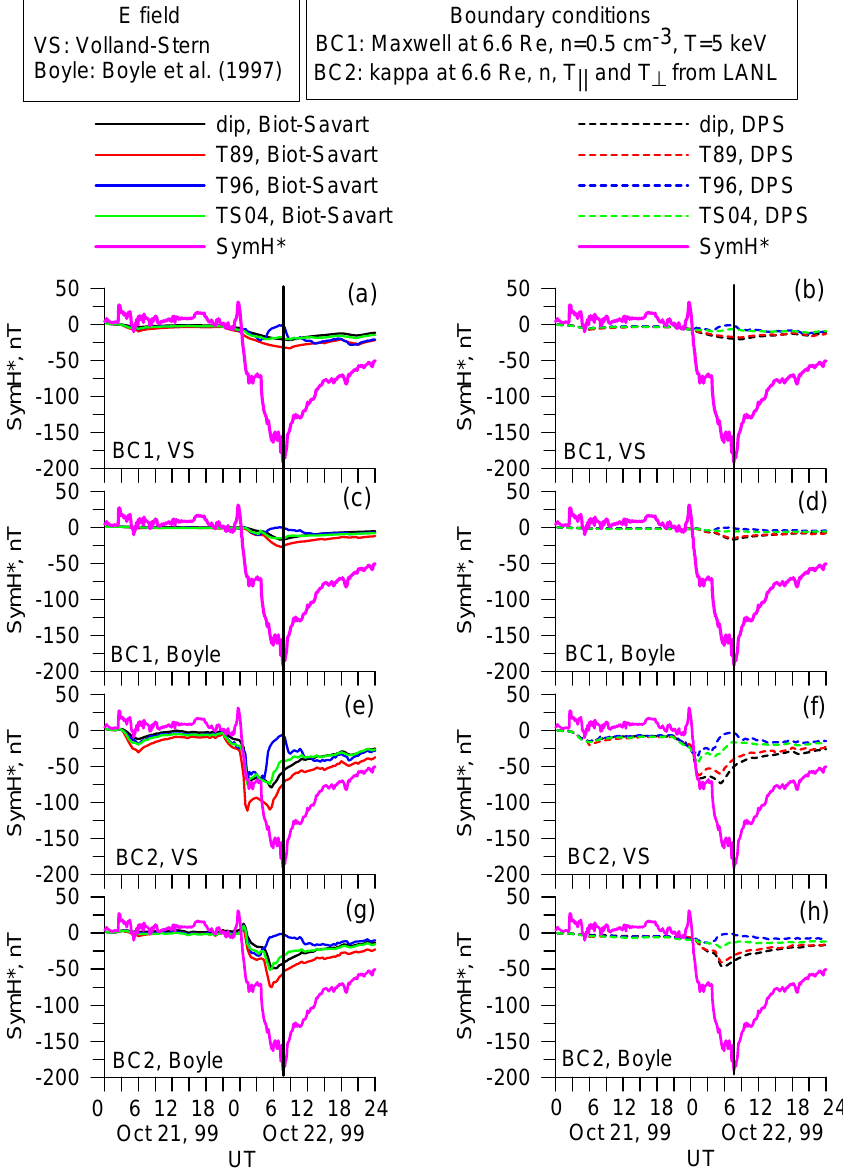
Fig. 10. Similar to Fig. 8 but for 21–22 October 1999 storm.